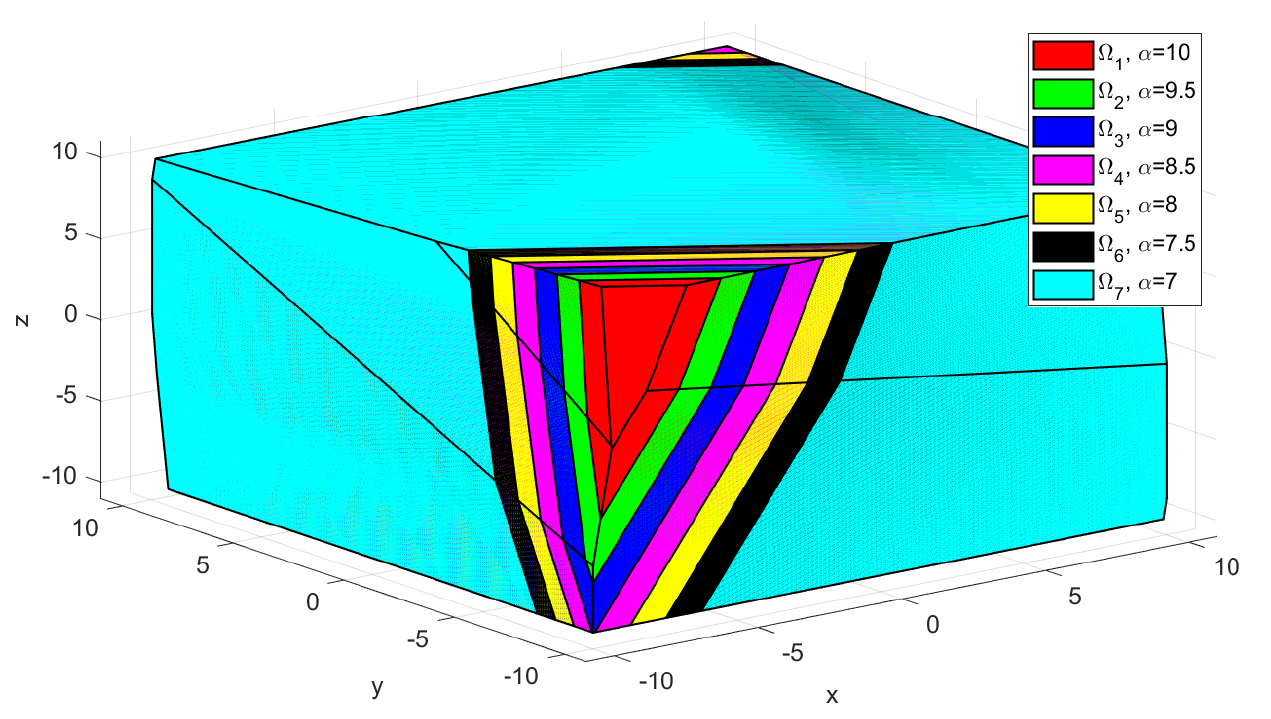
Figure 2. Case 1—Depiction of the predefined invariant sets corresponding to sub-system S 1, com- puted for uncertainty constraint limit value β = 0.1.